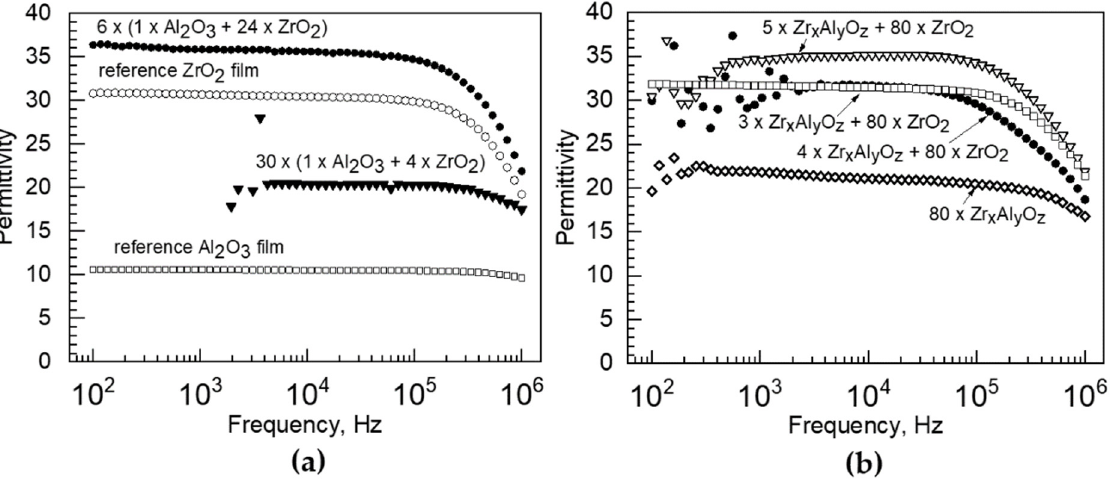
Figure 8. Relative dielectric permittivity versus measurement frequency curves for ( a ) periodically layered ZrO 2 :Al 2 O 3 stacks compared to those of reference ZrO 2 and Al 2 O 3 films and ( b ) stacks deposited by applying 3, 4 or 5 ALD cycles of interfacial Zr x Al y O z followed by 80 ALD cycles of ZrO 2 . The growth cycle sequences are indicated by the labels pointing via arrows to the corresponding dispersion curves. For the thicknesses and composition data, see Tables 1 and 2.